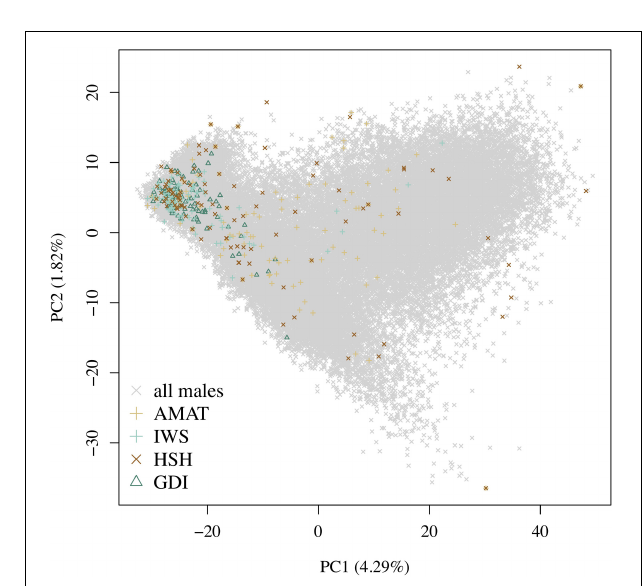
with a proportion of 5% or less non-target animals. HSH